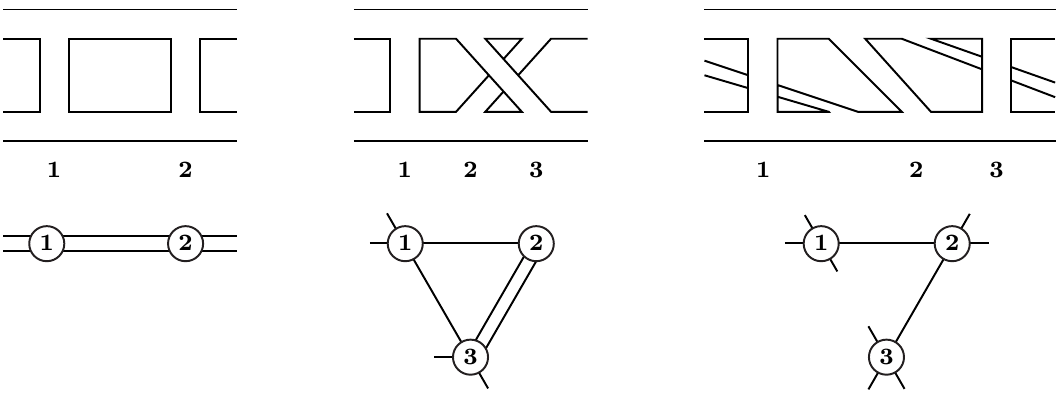
(cid:14) ( r ; q k ). Here p connects k =1